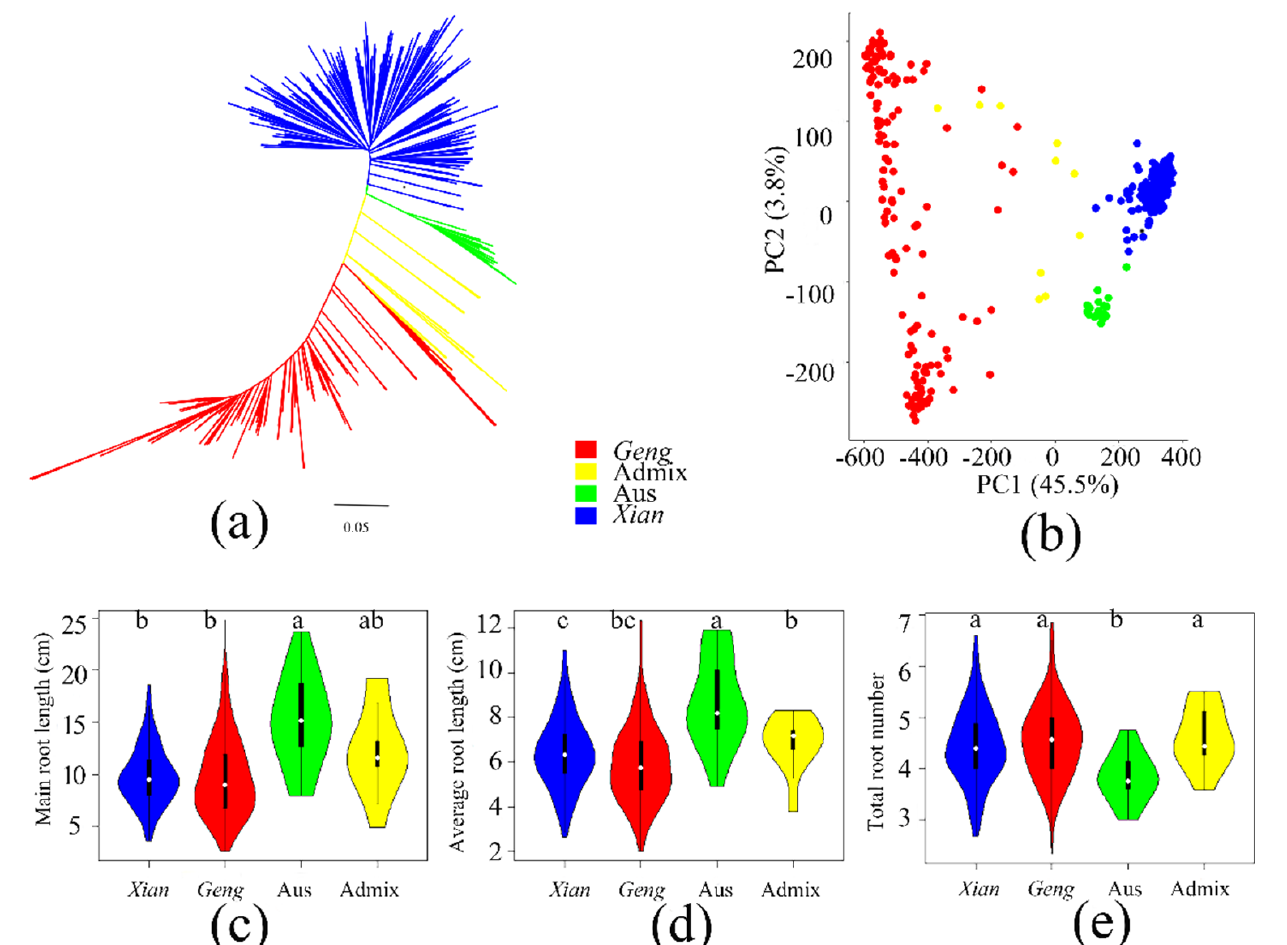
Figure 1. Phenotypic diversity of population structure and root traits of 391 rice accessions. ( a ) Based on the neighbor-joining tree of 391 samples, the filtered SNPs were calculated by a simple matching distance matrix; ( b ) Principal component analysis based on SNPs clearly distinguished Geng , Xian , Aus, and admix accessions, indicating different genetic backgrounds; Distribution of ( c ) main root length, ( d ) average root length, and ( e ) total root number among different rice populations. Different letters on the violins indicate statistically significant differences at p < 0.05 based on Tukey’s test.